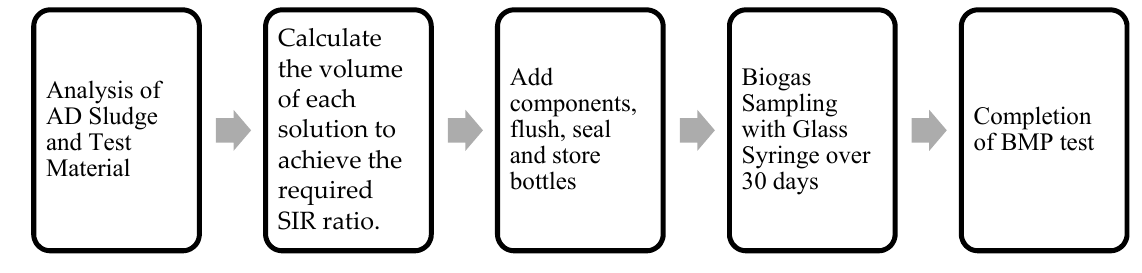
Figure 3. Flow diagram for BMP procedure .